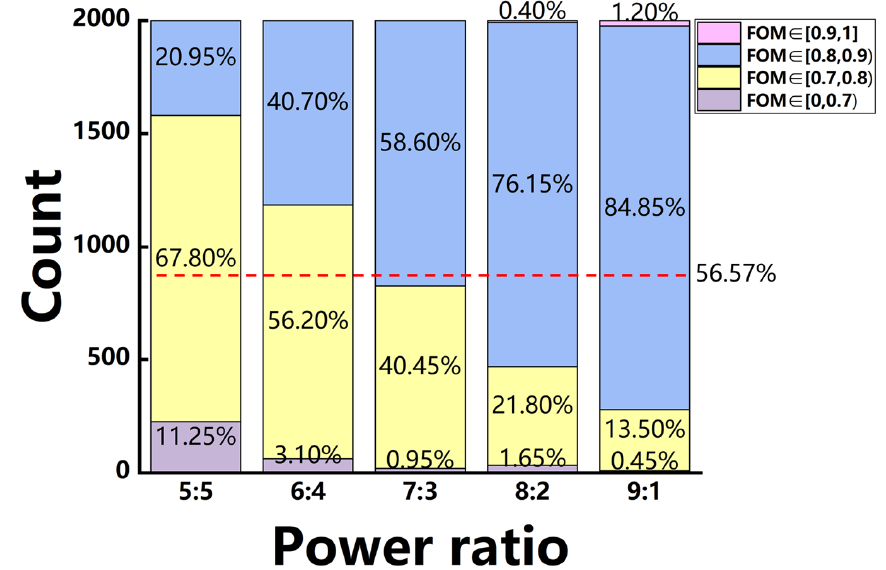
Figure 9. The histogram of FOMs for devices of five power-splitting ratios generated by the SAGAN-sim model. The red dashed line is for the averaged proportion of the devices with FOM over 0.8 for all five cases.